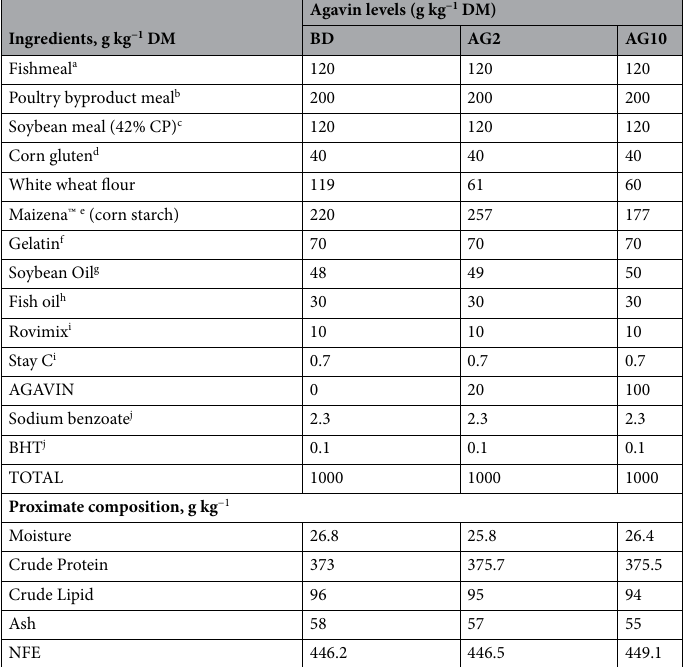
Table 1. Ingredients and proximate composition (g kg −1 on a dry matter basis, DM) of diets containing three levels of agavin (0, 2, and 10%) to feed shrimp juveniles ( Litopenaeus vannamei ) under commercial conditions. NFE (g kg −1 ) = 100% − (crude protein + crude lipid + ash + moisture). a Sardine fishmeal from Proteínas Marinas y Agropecuarias SA de CV, Guadalajara, Jalisco, Mexico. b Pet food grade (65% CP and 14%CF) from Proteínas Marinas y Agropecuarias SA de CV, Guadalajara, Jalisco, Mexico. c Alimentos COLPAC, Hermosillo, Sonora, CV, Léon, Guanajuato, México. g Cargill, Minnesota USA. h from sardin (Mazatlán, México). i DSM